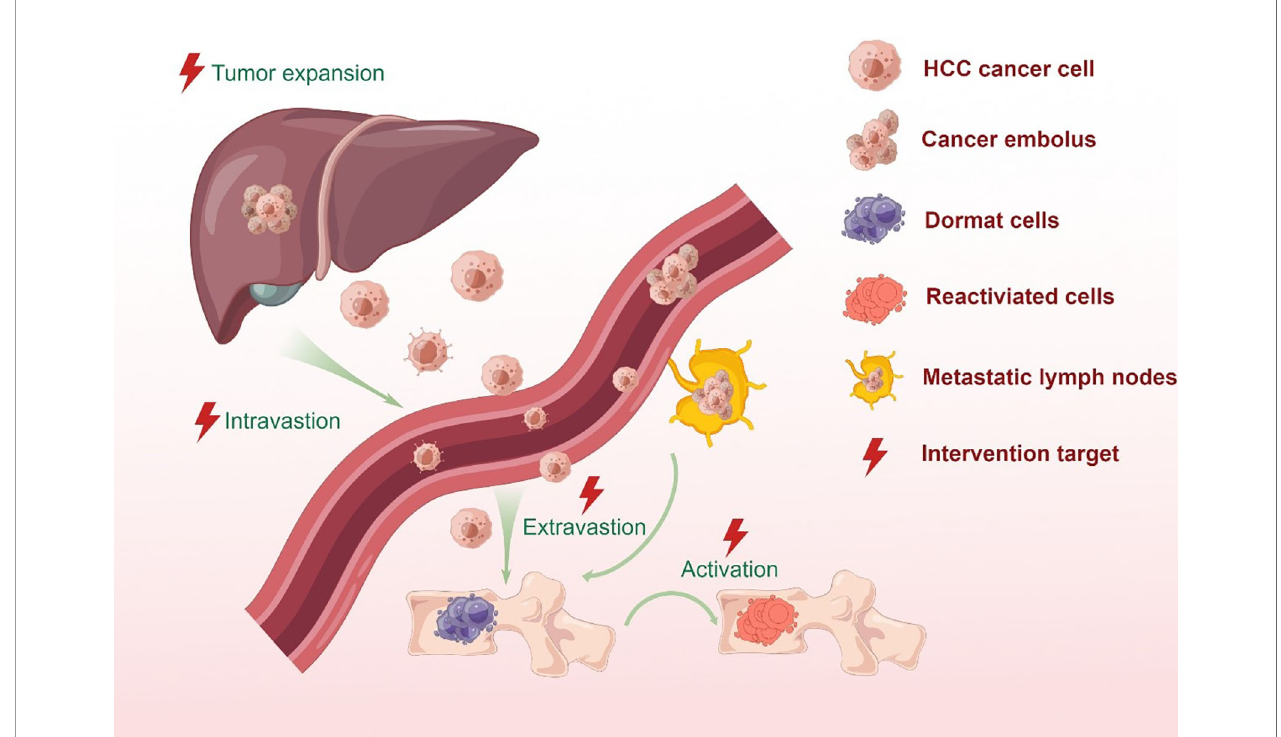
FIGURE 1 | Bone metastatic steps of HCC cells. In situ hepatocellular carcinoma results from the mutation of protooncogenes or suppressor genes in normal cells as a combined result of physical, chemical or biological factors. Cancer cells stimulate angiogenesis to ful fi ll its nutritional needs. During tumor growth, the extracellular matrix is dissolved, which causes the invasion of the lymphatic and circulatory systems. But only a small proportion of cancer cells can survive and form a tumor thrombus in the circulatory system due to immune surveillance. Meanwhile, CTCs and ctDNA can be detected by the liquid biopsy for monitoring tumor in real time. At the proper time, the surviving cells migrate from the circulatory system to the target organ or tissue and colonize the area. Metastatic tumor cells in distant locations are inactive for a period of time in order to adapt to stress stimuli and survive a hostile environment. When stimulated by an appropriate signal, dormant tumor cells become active and continue to behave in a malignant